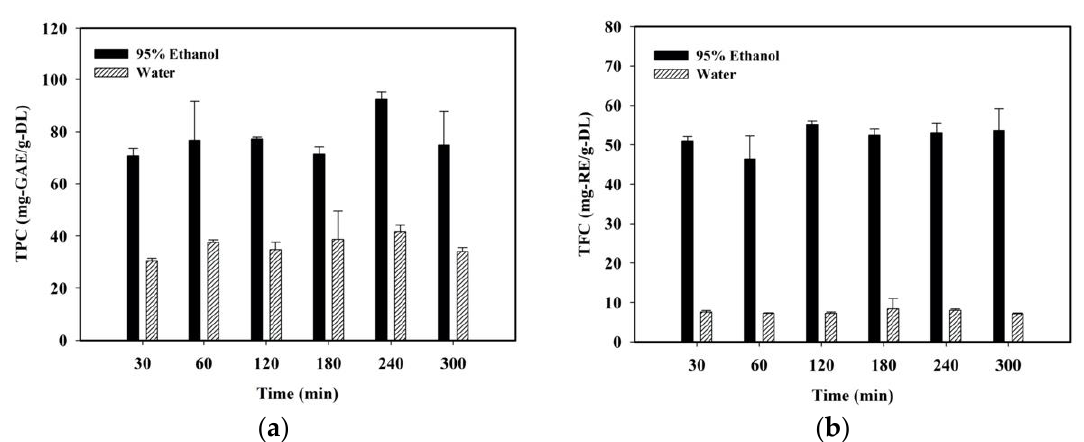
Figure 3. Variation of ( a ) TPC and ( b ) TFC against the extraction time by using 95% ethanol or water as the solvent. Conditions: DL/solvent = 1/10 (g/mL), UAE at 40 kHz/300 W of ultrasound, 30 °C. Data were expressed as mean ± standard deviations from triplicate experiments.